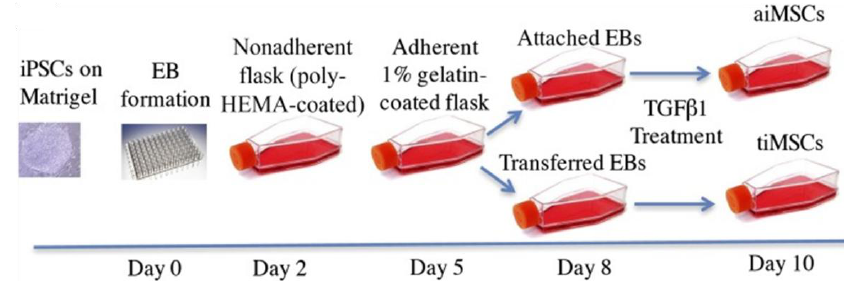
Figure 6. Schematic summarizing the di ff erentiation procedure of iPSCs into 2 cell populations